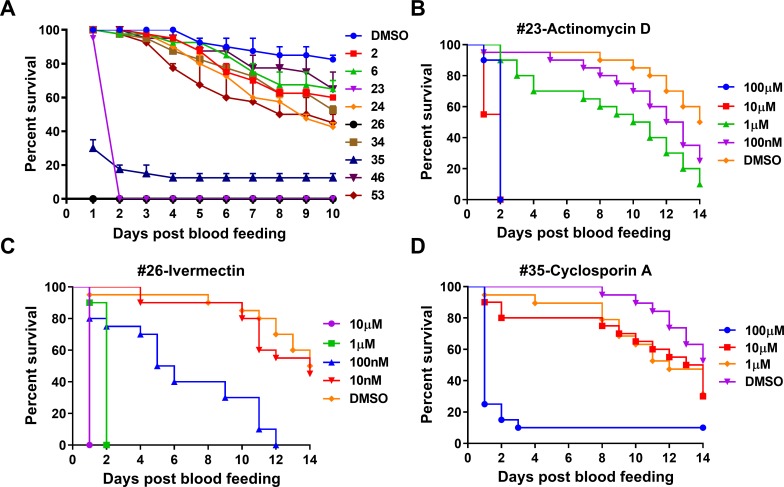
Adult mortality of Aedes aegypti fed on the nine selected anti-flaviviral drugs via a blood meal.A, Survival rates of adult females fed on the selected drugs. One-week old female mosquitoes were provided a blood feeding supplemented with each drug at a final concentration of 100 μM. The dead mosquitoes were counted each day for 10 days, and survival rates were calculated. Survival curves for adult female Ae. aegytpi fed with Act-D (B), ivermectin (C), or cyclosporin A (D) at various concentrations of each drug in the blood meal. The experiments were repeated twice, and one replicate was presented.